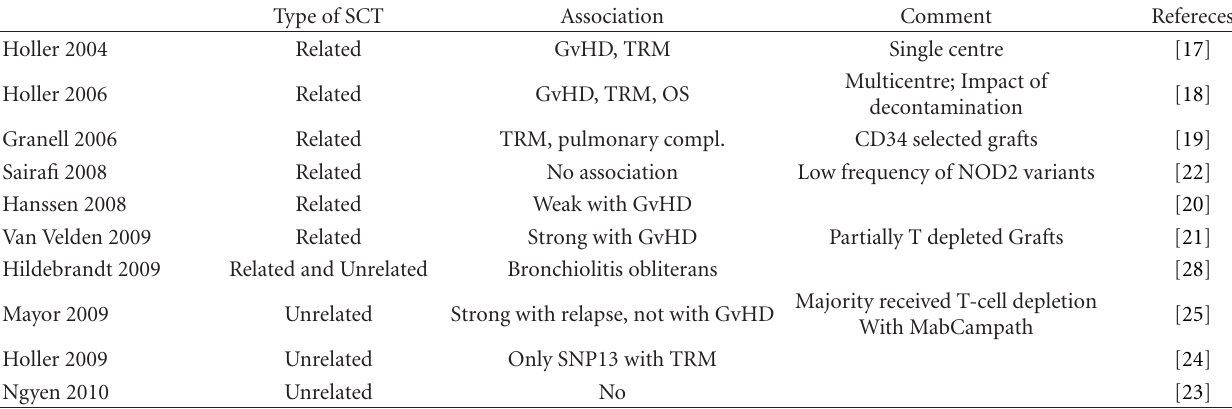
Table 1: Summary of published studies on NOD2 SNPs and outcome following